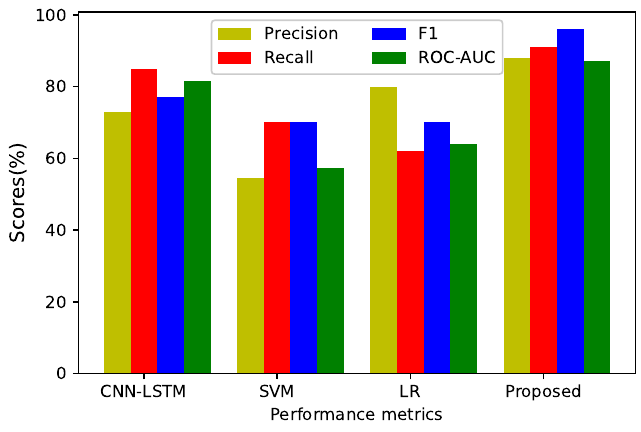
Figure 12. Performance comparison.